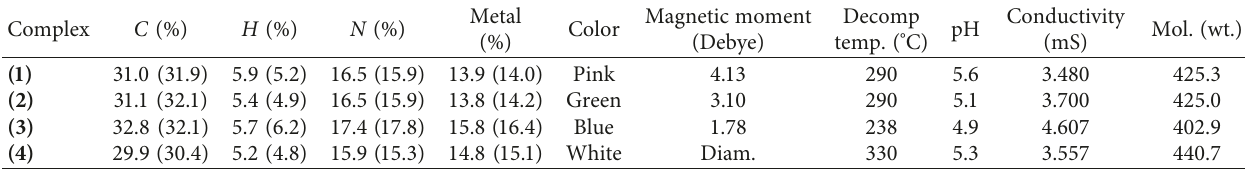
Table 1: Some experimentally observed and determined characteristics of the prepared complexes (found values between parentheses).